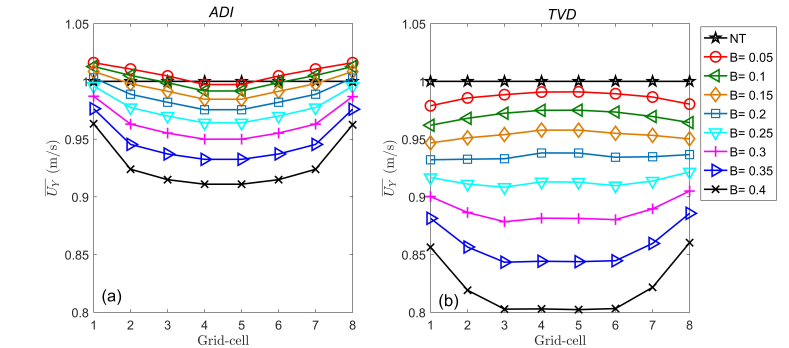
Figure 4. Blockage ratio effect on normalised upstream velocities along a partial fence, ADI ( a ) and TVD ( b ). Natural state flow condition is indicated by